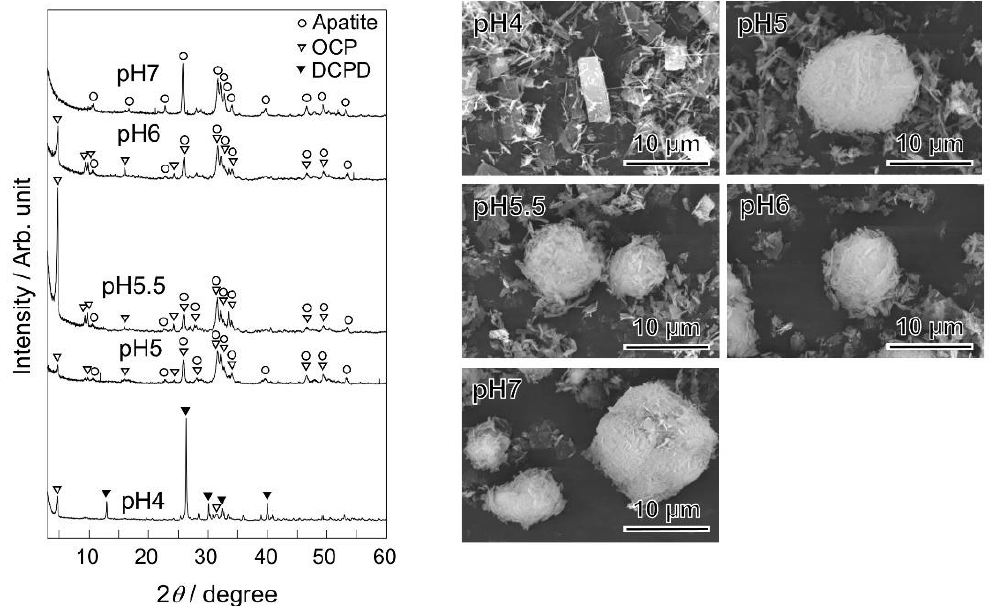
Figure 2. X-ray diffraction patterns and scanning electron microscope photographs of the micro- spheres obtained by H 3 PO 4 treatment of the calcite microspheres at various pH values.